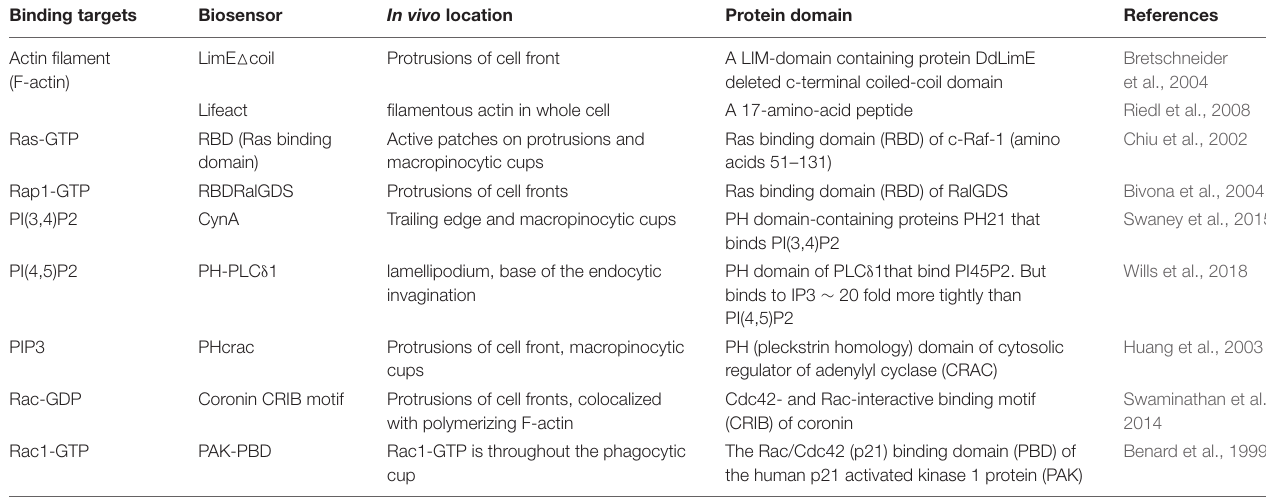
TABLE 2 | Examples of well-characterized biosensors for important activities in the celll migration